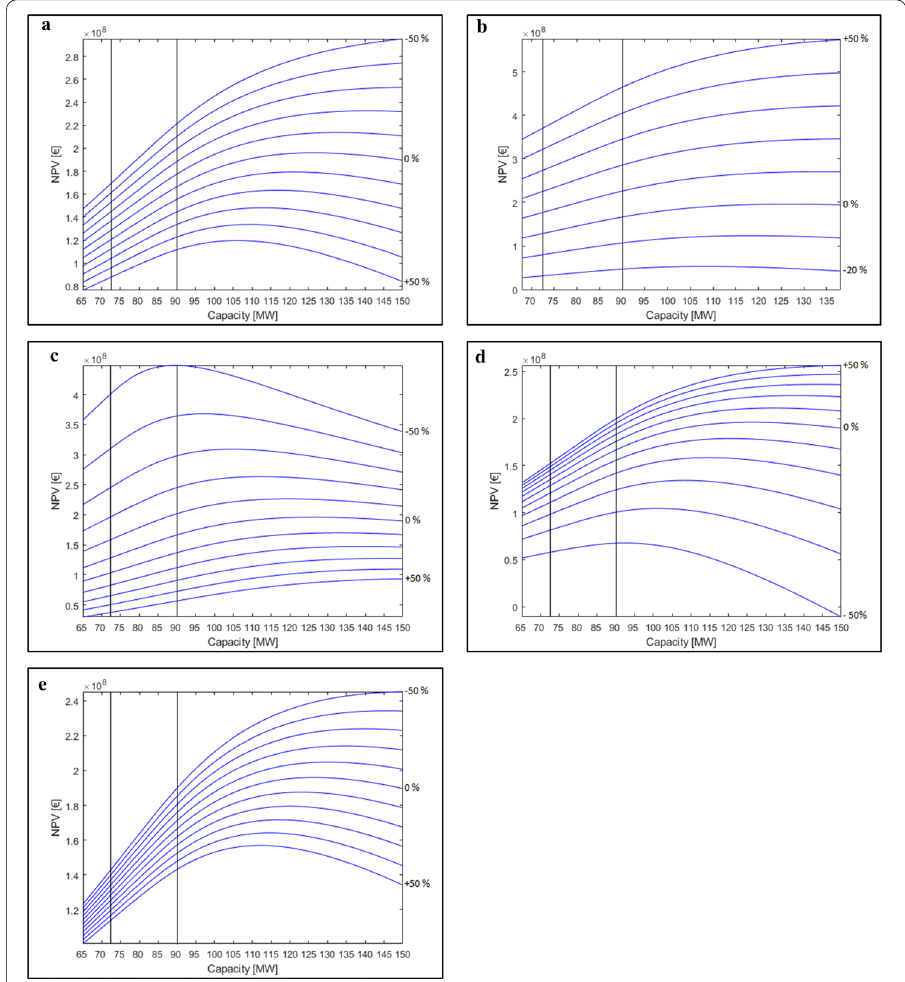
Fig. 5 Sensitivity analysis for key parameters on the optimization results—Case 1. The vertical lines represent the production within “sustainable manner boundaries” in the sense of 100 (right vertical line) to 300 years (left vertical line) of reservoir lifetime. a Variation of subsurface cost; b variation of electricity price; c variation of interest rate; d variation of average well productivity; e variation of production